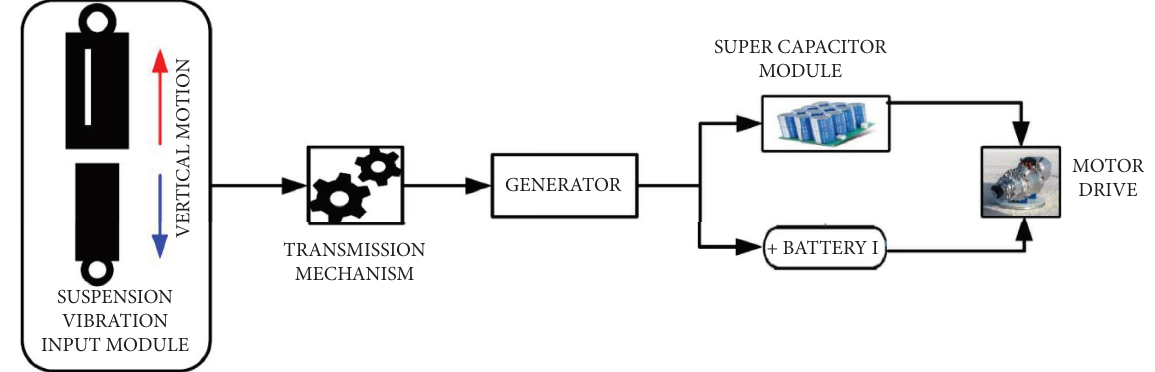
Figure 5: A simple block diagram of ER-RSA